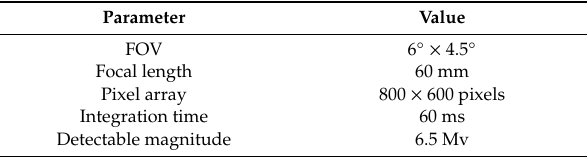
Table 1. Parameter of star sensor.